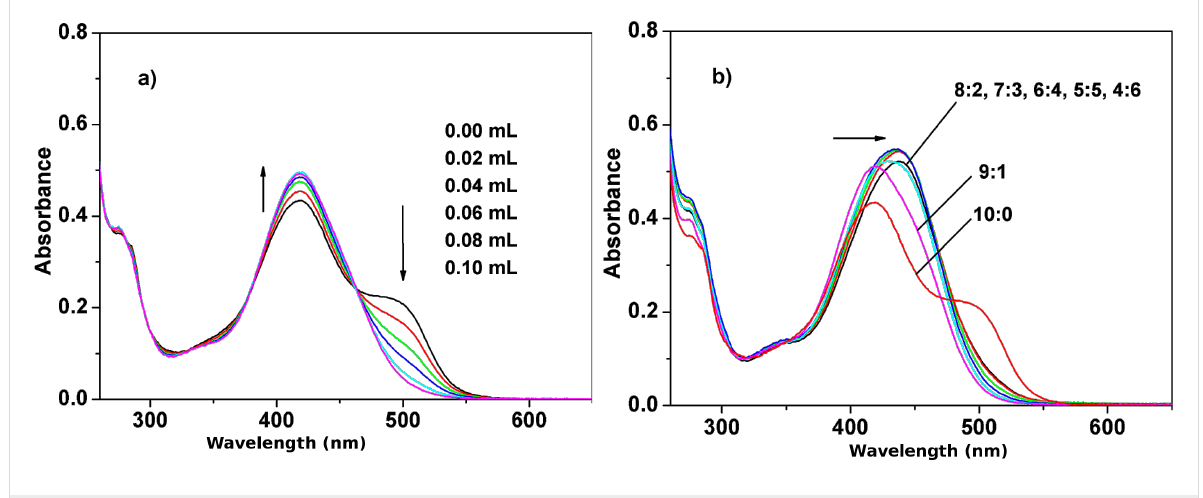
Figure 2: Changes in UV–vis spectra of 1 (5.0 × 10 − 5 M) after addition of: (a) 0–0.10 mL H 2 O; (b) various ratios of the CH 3 CN/H 2 O (fixed volume is 4 mL).